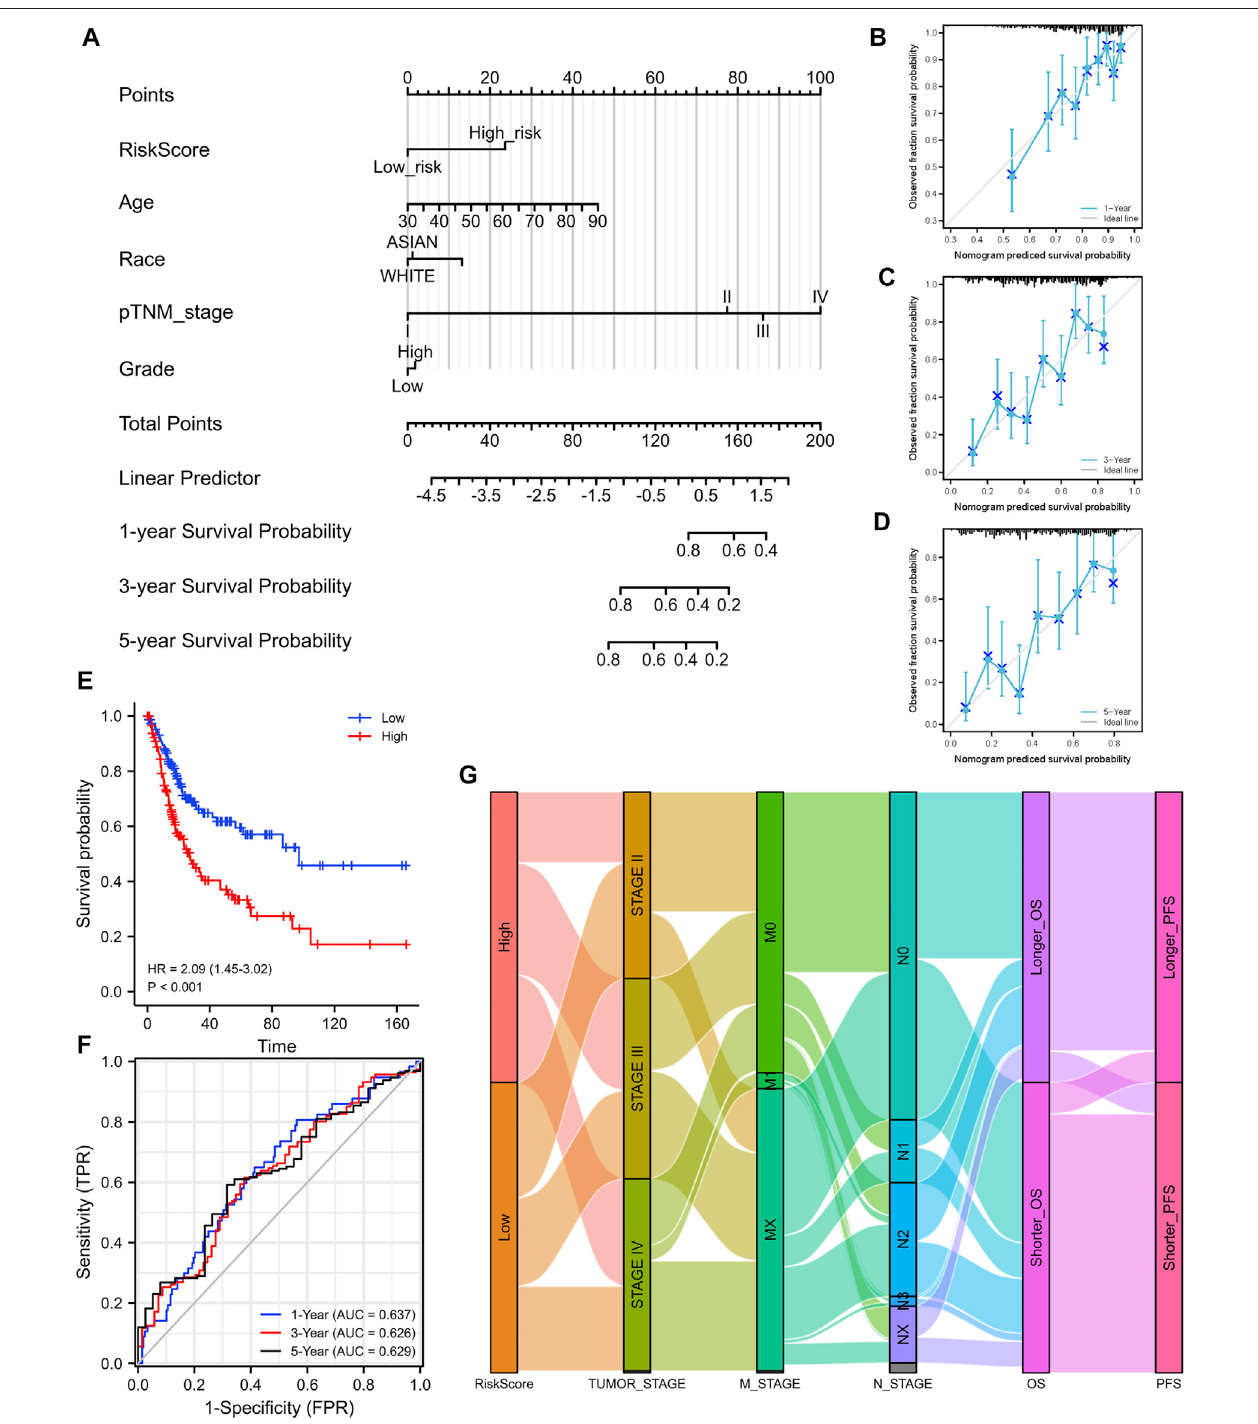
FIGURE6| Constructionofanomogramandtheindependentsignaturevalidation. (A) Nomogramforpredicting1-,3-,or5-yearOSinpatientswithBLCA. (B) The calibration plots for predicting 1-year OS. (C) The calibration plots for predicting 3-year OS. (D) The calibration plots for predicting 5-year OS. (E) Validation of the signature inoverall survivalbasedon datafrom the cBioPortal online database. (F) TheROCcurves ofthe signature validation foroverall survivalat 1, 3,and 5 years. (G) Sankey diagram showing the association between signature risk scores and clinicopathological characteristics based on data from the cBioPortal database. OS: overall survival. ROC: receiver operating characteristic.